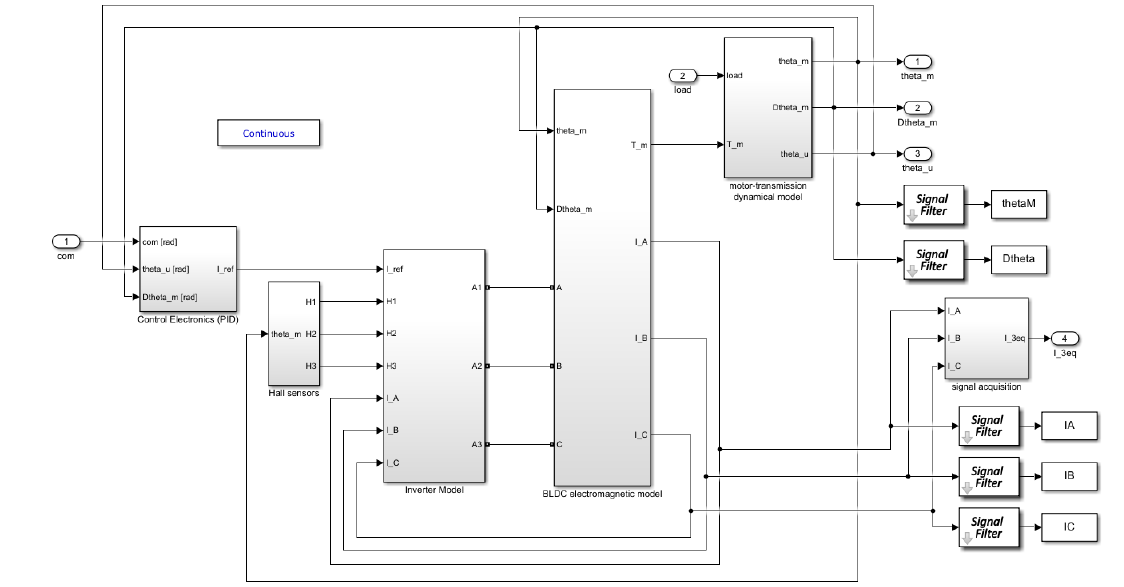
Figure 3. Trapezoidal EMA subsystem [33].